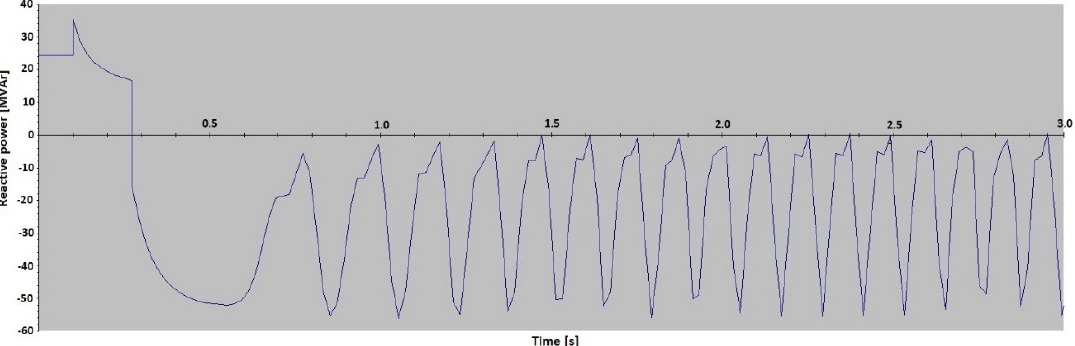
Figure 23. Simulation results of active power of Generator 2 during the three-phase fault with the fault duration of 172 ms.